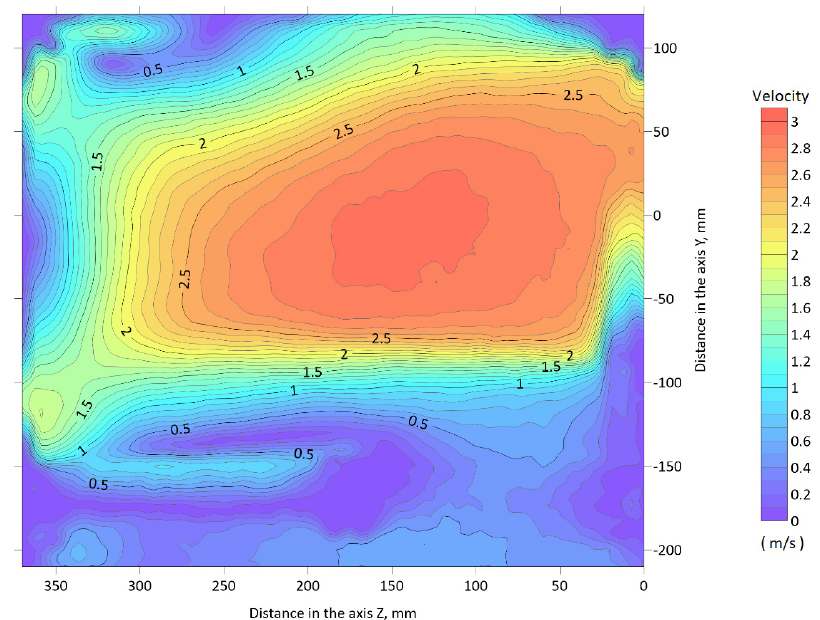
Figure 9. Averaged air velocity field in the plenum box from air motion along the Y-axis and Z-axis in the Z-Y plane passing through the center of the plenum box spigot.